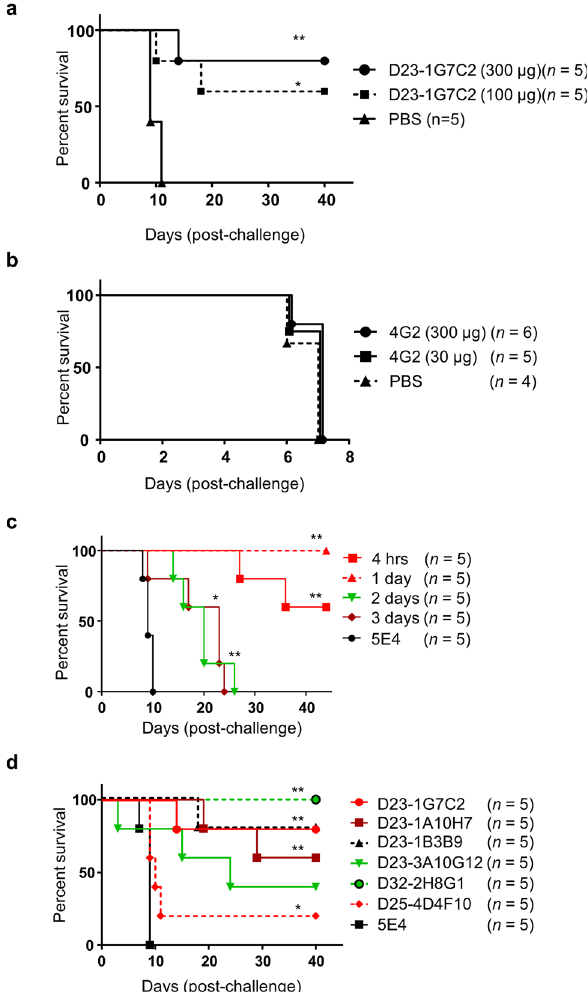
Figure 4. Protection of mice from challenge with chimeric flavivirus by monoclonal antibodies. ( a ) IFN-α/ βR–γR double-knockout (dKO) mice ( n = 5 per group) were intraperitoneally infected with 8.0 × 10 2 focus- forming units (FFU) per animal of DV2ChimV, followed after 4 h by intraperitoneal injection with 300 µg or 100 µg D23-1G7C2 human monoclonal antibody (HuMAb), or with phosphate-buffered saline (PBS). Statistical differences in survival were observed with D23-1G7C2 relative to PBS. Kaplan–Meier survival curves show the percentage of mice surviving at the specified days post-infection. Statistical differences between individual groups to mock-infected (PBS) control were evaluated by the log rank (Mantel-Cox) test. * P < 0.05, ** P < 0.01. ( b ) IFN-α/βR–γR dKO mice ( n = 4–6 per group) were intraperitoneally infected with 8.0 × 10 2 FFU per animal of DV2ChimV, followed after 4 h by intraperitoneal injection with 300 µg or 30 µg 4G2 mouse monoclonal antibody, or with PBS. Kaplan–Meier survival curves show the percentage of mice surviving at the specified days post-infection. Statistical differences between individual groups to the mock-infected (PBS) control were evaluated by the log rank (Mantel–Cox) test. No significant difference was found. ( c ) Effect of timing of treatment with HuMAb. IFN-α/βR–γR dKO mice ( n = 5 per group) were infected with 8.0 × 10 2 FFU per animal of DV2ChimV and then injected with 300 µg D23-1G7C2 at 4 h, 1 day, 2 days, or 3 days post-infection (p.i.), or with the anti-influenza antibody 5E4 at 4 h p.i. Statistical differences in survival were observed with D23-1G7C2 relative to 5E4. Kaplan–Meier survival curves show the percentage of mice surviving at the specified days post- infection. Statistical differences between individual groups and the isotype IgG (5E4) control were evaluated by the log rank (Mantel–Cox) test. * P < 0.05, ** P < 0.01. ( d ) IFN-α/βR–γR dKO mice ( n = 5 per group) were intraperitoneally infected with 8.0 × 10 2 FFU per animal of DV2ChimV, followed by intraperitoneal injection with HuMAbs against DENV E-protein (D23-1G7C2, D23-1A10H7, D23-1B3B9, D23-3A10G12, D25-4D4F10, and D32-2H8G1) or against influenza virus (5E4). Statistical differences in survival were observed with anti-E HuMAbs relative to 5E4. Kaplan–Meier survival curves show the percentage of mice surviving at the specified days post-infection. Statistical differences between individual groups to the isotype IgG (5E4) control were evaluated by the log rank (Mantel–Cox) test. * P < 0.05, ** P <